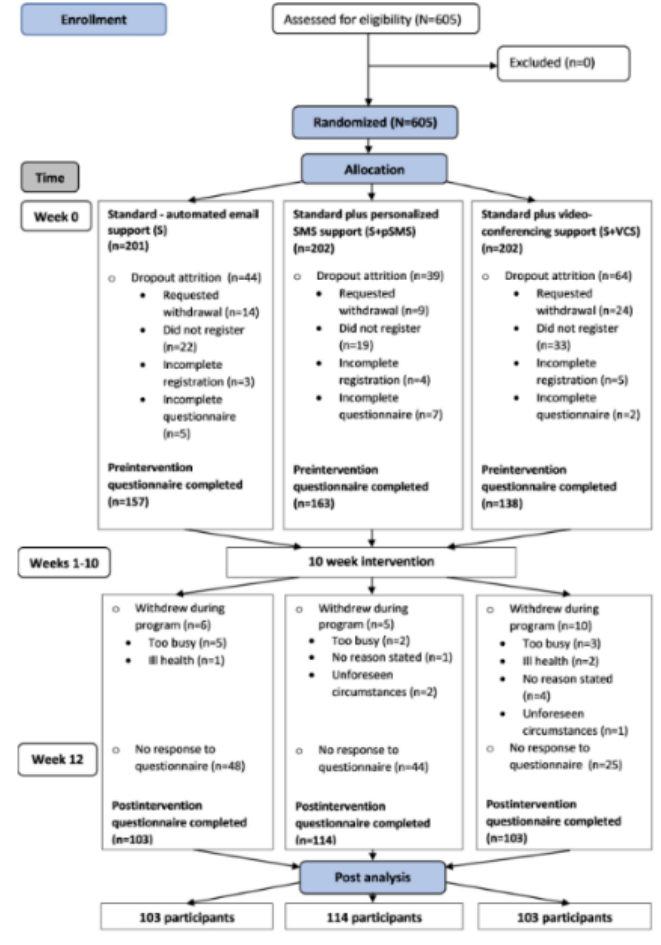
Figure 1. Flow of